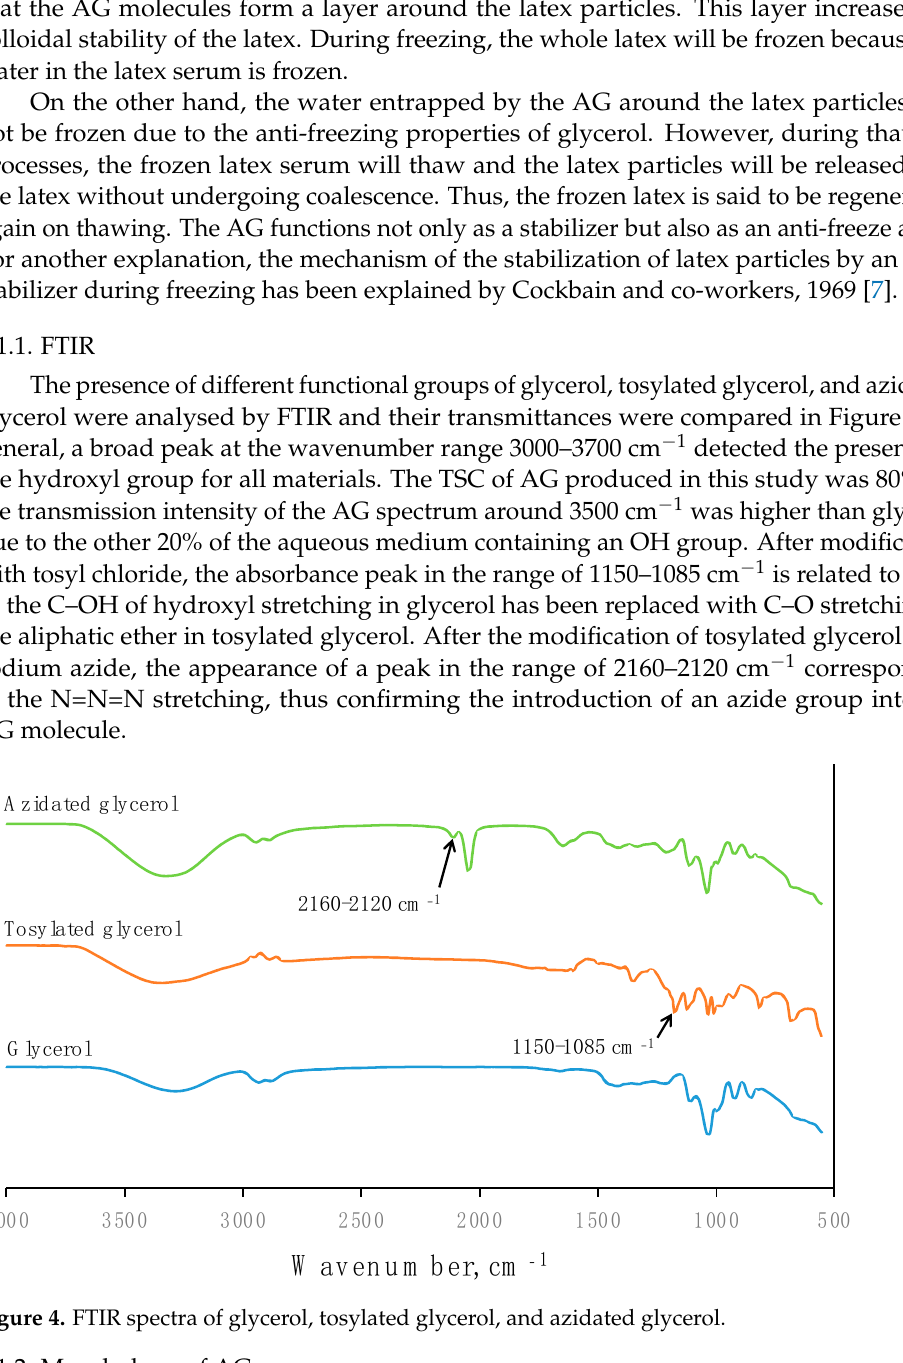
Figure 5. Images of crystal formation of 80% TSC AG by ( a ) the naked eye and ( b ) optical microscopy of aggregation of AG by Dino-Lite at a magnification of 50×. 3.2. Effect of Variable Loading of AG on the Colloidal Properties f NRL before and after the Freeze–Thaw Processes Figure 6 shows a TEM image of the NRL particles at 0 phr of AG (NRL without sta- bilizer). It is observed that grey rings, which are the membrane layers derived from pro- tein lipid, surround the particles. The rubber particles are believed to be covered by some proteins and phospholipids, concerning the colloidal stability of natural rubber latex [17]. Phospholipids are strongly adsorbed to the surfaces of the rubber particles and are be- lieved to be the intermediate by which the proteins are anchored to the rubber particles [18].